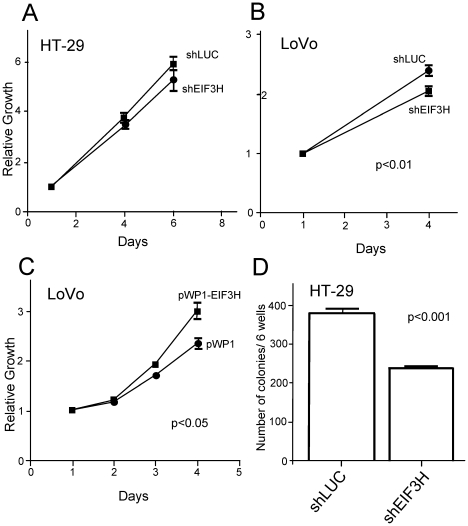
Impact of differential EIF3H expression on growth of colorectal cancer cell lines.CRC cell line growth based on AlamarBlue analysis. (A) HT-29 cells transduced with shRNA against EIF3H (shEIF3H) and control (shLUC). No effect on cell growth is seen. (B) LoVo cells transduced with shRNA against EIF3H (shEIF3H) and control (shLUC). Suppression of EIF3H reduced the cell growth of LoVo. (C) LoVo cells transduced with lentivirus carrying EIF3H expression vector (pWP1-EIF3H) and empty vector control (pWP1). The EIF3H overexpression increased significantly the cell growth of LoVo. Mean values ±SEM are shown. (D) Impact of EIF3H expression on anchorage-independent growth of HT-29 colorectal cancer lines in soft agar assay. HT-29 cells transduced with pLL3.7 lentivirus carrying shRNA against EIF3H (shEIF3H) or against luciferase (shLUC) were grown in soft agar followed by counting the colonies. Approximately 40% reduction in the number of colonies was found. Mean values ±SEM are shown.